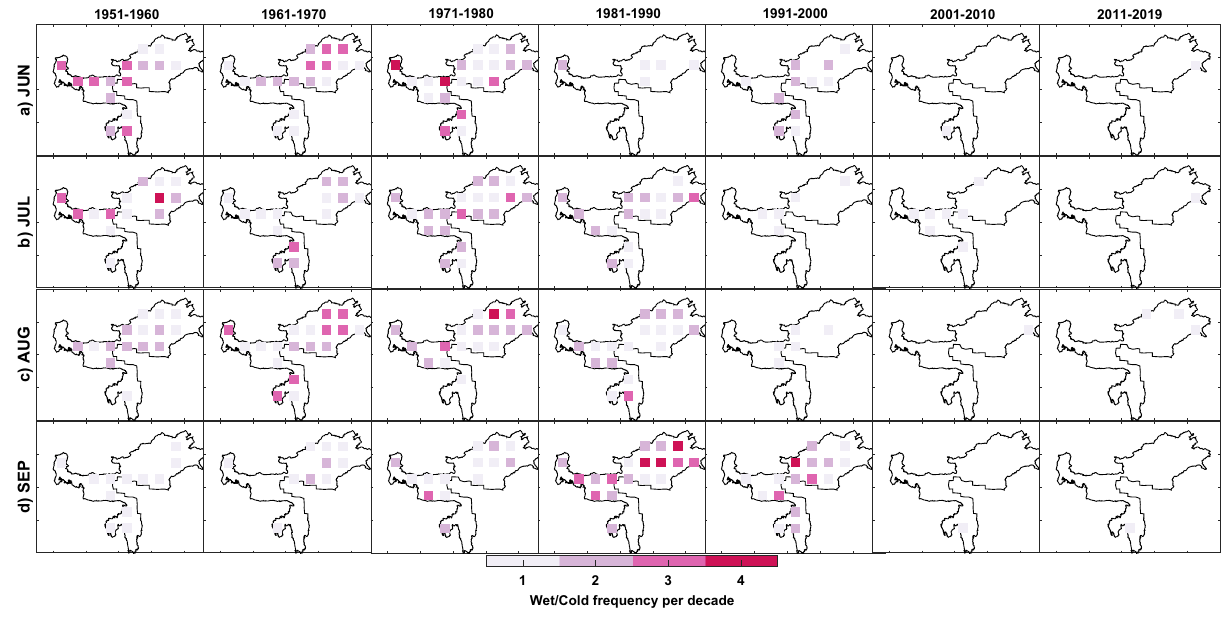
Figure 6. Geographical representation of spatial extent over North-eastern homogenous region during ( a ) June, ( b ) July, ( c ) August and ( d ) September. Colorbar represents the number of months shown with the occurrence of CWCE during the decade at each grid point. This figure is generated using Mapping Toolbox in MATLAB R 2020b (Version 9.9 https:// in. mathw orks. com/ produ cts/ mappi ng. html).